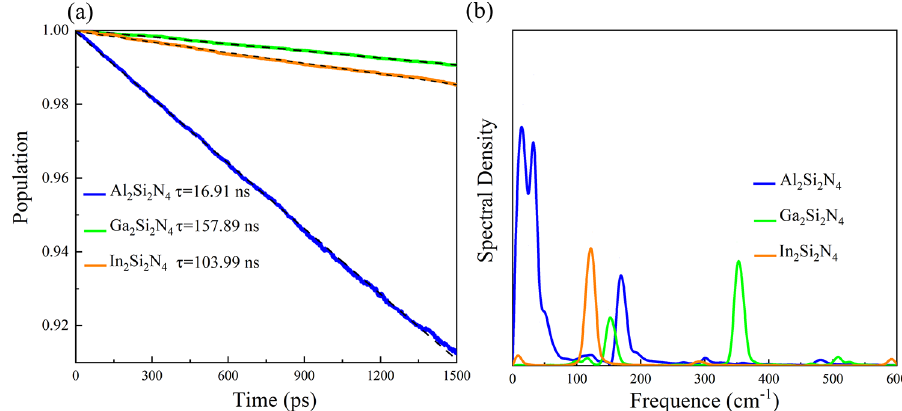
Figure 7. Excited–state carriers’ population decay ( a ) and spectral densities ( b ) of M 2 Si 2 N 4